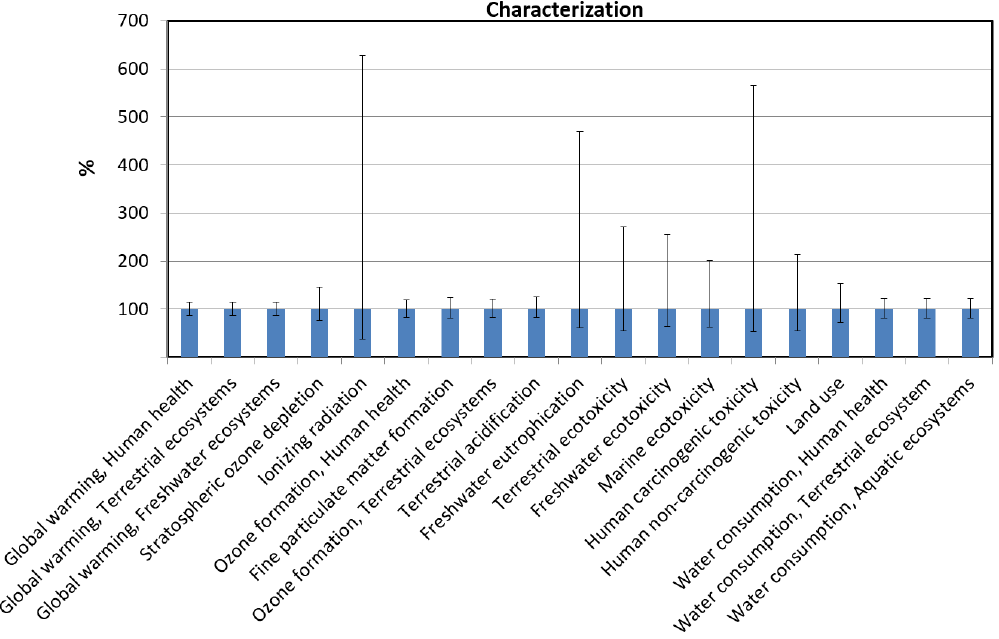
Figure 14. Uncertainty analysis outcome for LiIo batteries.